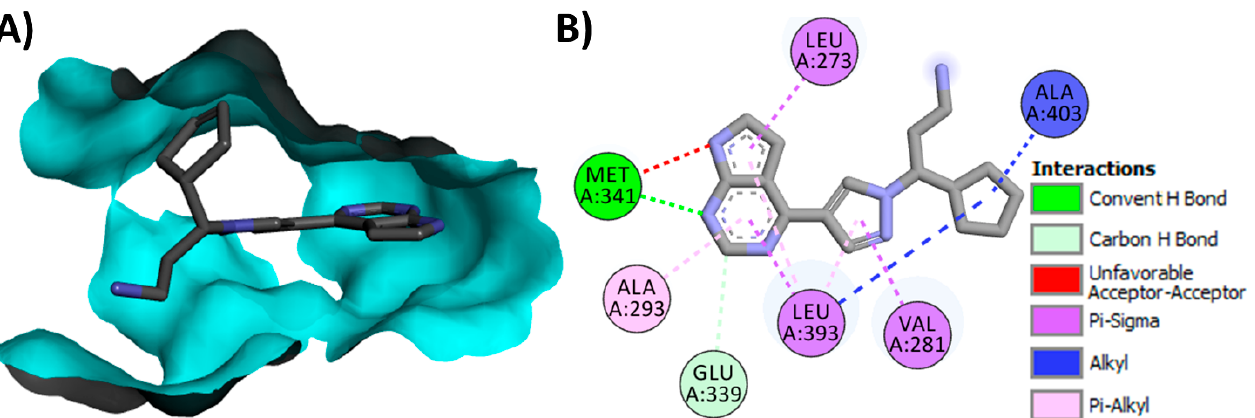
Figure 56. Binding modes of ruxolitinib (shown as sticks) into the DCLK1 kinase domain (pdb: 7F3G): ( A ) 3D binding mode, receptor shown as a hydrogen bond surface; ( B ) 2D binding mode showing different types of interactions with DCLK1 kinase domain; hydrogen atoms were omitted for clarity; this figure was generated using Discovery Studio Visualizer (V16.1.0.15350). Pharmacological Activities and Uses Ruxolitinib is a JAK1/2 inhibitor which showed the strong inhibition of JAK2V617F- positive Ba/F3 cells [167]. The efficacy of ruxolitinib in the treatment of myelofibrosis was evaluated in several clinical trials [167,168]. The results of the clinical trial (NCT00952289) revealed significant therapeutic outcomes compared to placebo [168]. In addition to its inhibitory activity against JAKs, ruxolitinib also targets other ki- nases such as CHK2 and c-Met [166]. Furthermore, ruxolitinib exhibited antiproliferative activity against JAK2V617F+ Ba/F3 cells at IC 50 127 nM [166]. The combination of rux- olitinib and ERBB1/2/4 inhibitors also displayed synergistic anticancer activity against lung, breast, and ovarian cancer cells [169]. In 2019, Kim et al. [170] investigated the efficacy of ruxolitinib cream in the treatment of atopic dermatitis in a phase 2 study. A fast improvement in the symptoms of atopic